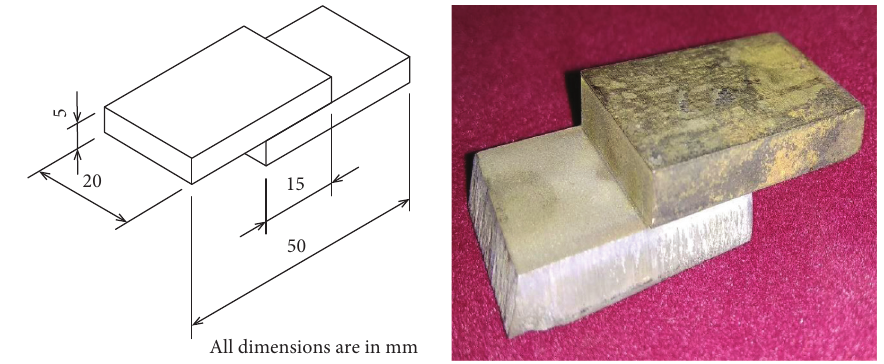
Figure 4: Lap shear tensile test specimen details.